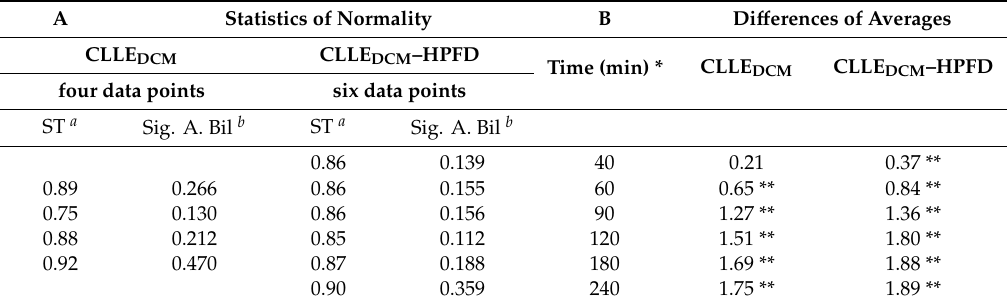
(Table 6A). The results of the χ 2 test indicated that the mean weights of the solvent-free extracts collected at di ff erent time points in these replicates were independent ( p > 0.05) (Table 7). Table 6. Statistics of the ( A ) normality test (Shapiro–Wilk) and of ( B ) multiple comparisons (HSD Tukey) applied to the data from the CLLE DCM and CLLE DCM –HPFD of industrial wastewater (WW).